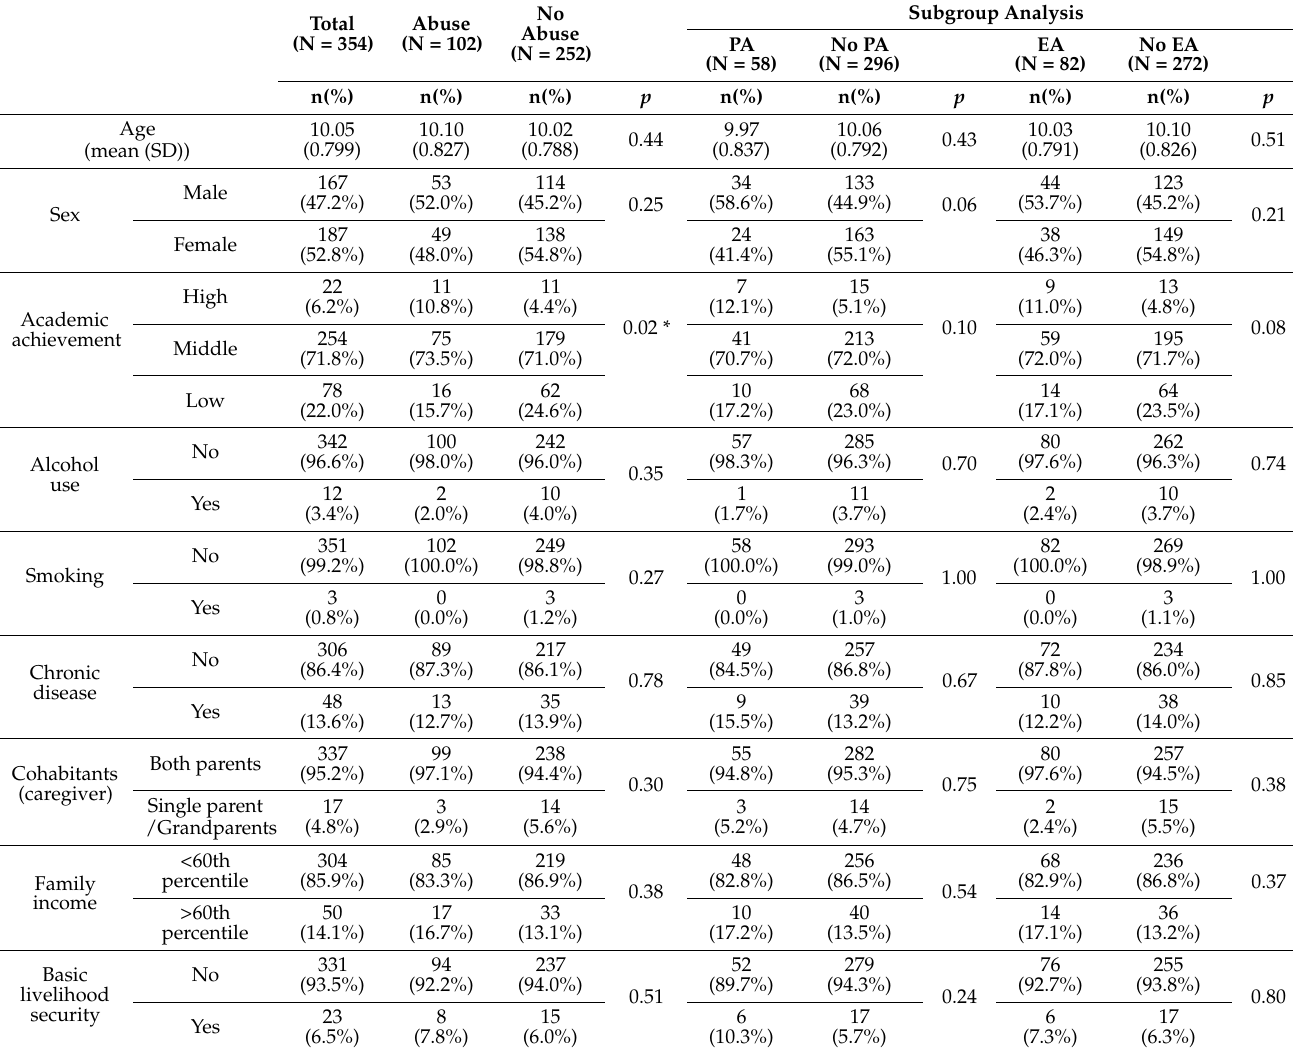
Table 1. Socio-demographic characteristics of participants at baseline.